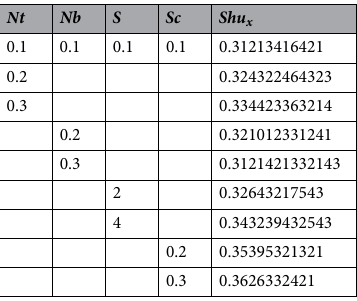
0.5 Table 3. Shu x Re − x numerical values versus various parameters.